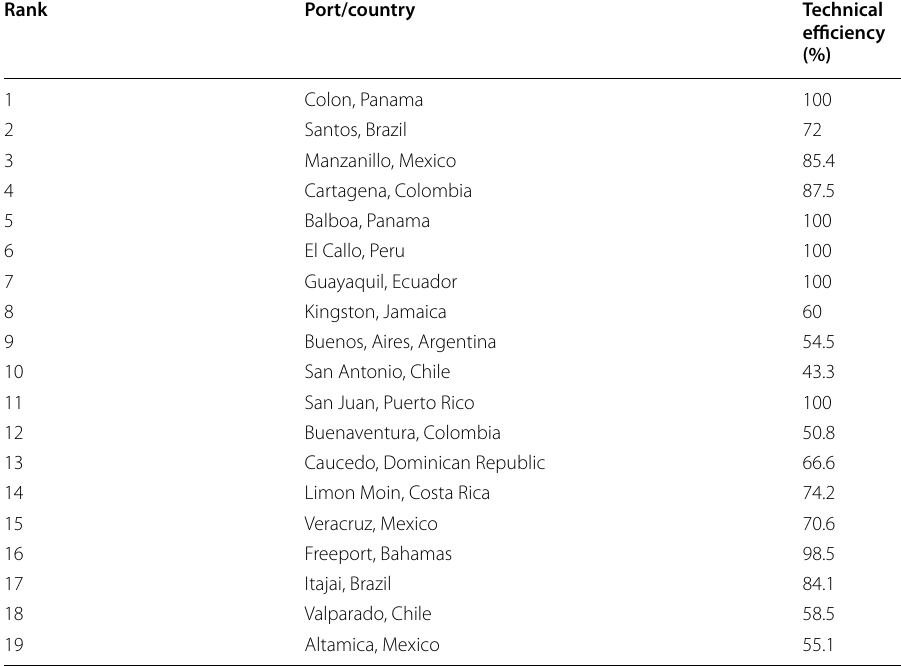
Table 6 Technical efficiency results for the 19 LAC ports. Period 2010–2018. Source : Own elaboration Rank